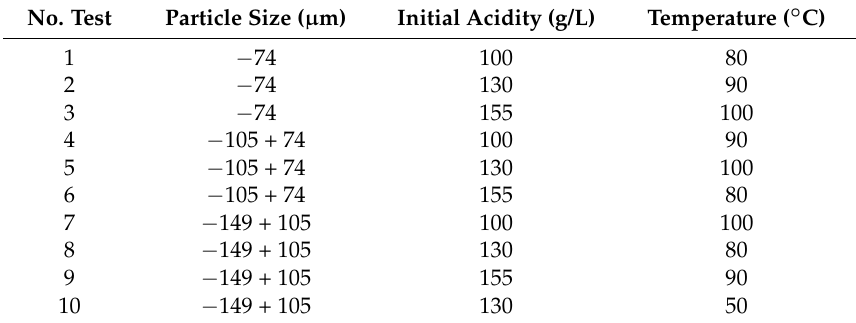
Table 5. Taguchi L9 experimental